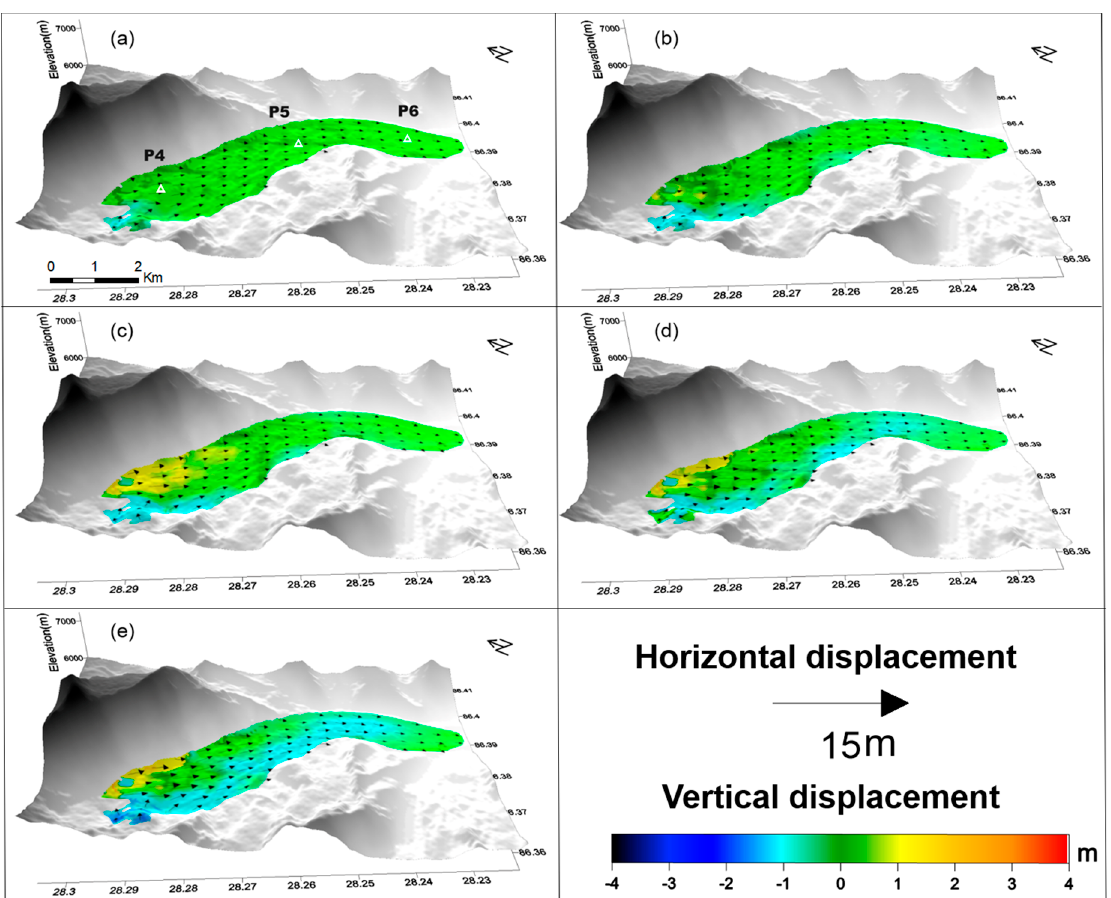
Figure 7. Time series of 3D displacement for glacier No.2 from 23 January to 25 December, 2018. Color represents the vertical displacement and arrows represent the horizontal displacement. ( a ) 20180123– 20180429; ( b ) 20180123–20180604; ( c ) 20180123–20180803; ( d ) 20180123–20181002; ( e ) 20180123– 20181225.